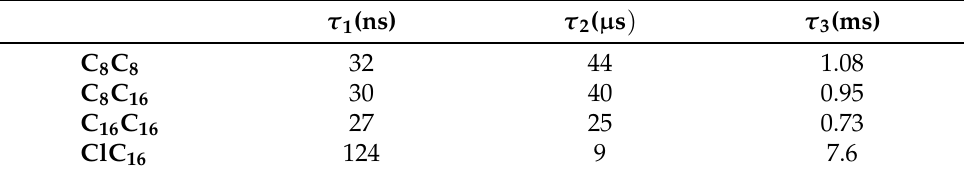
Table 3. Lifetimes obtained from globally fitting the nanosecond transient absorption experiments using a three-step sequential model. The solvent used is DCM unless noted otherwise.